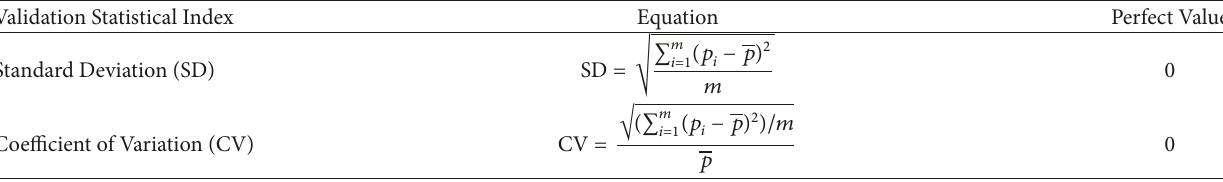
Table 2: List of the statistical indices for validation used to detect variations in a neighbourhood’s housing prices between websites.